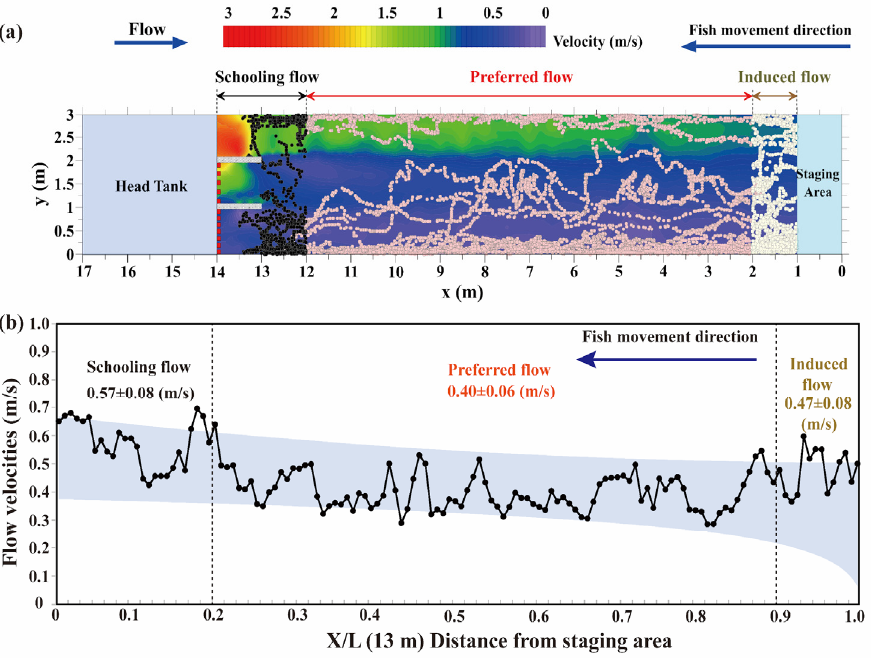
Figure 7. ( a ): Classification of the flow velocity as induced, preferred, and schooling flow based on the different fish swimming schemes; ( b ) 95% confidence intervals of the flow velocity range and fish movement distance.